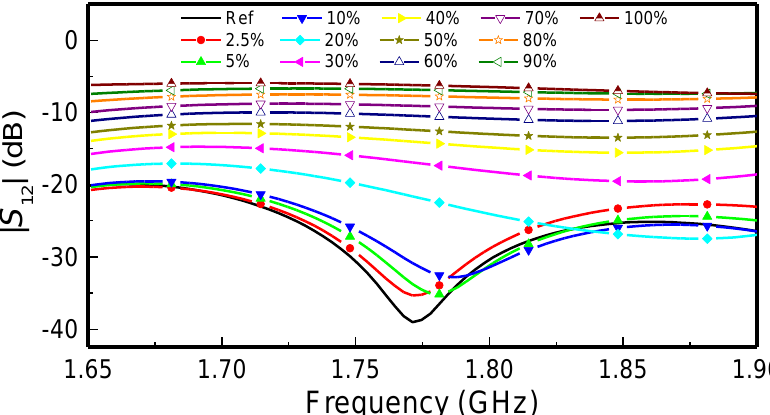
Figure 34. Frequency response of the sensing structure for different concentrations of isopropanol in DI water injected in the MUT channel, and pure DI water injected in the REF channel. From [69], reprinted with permission.